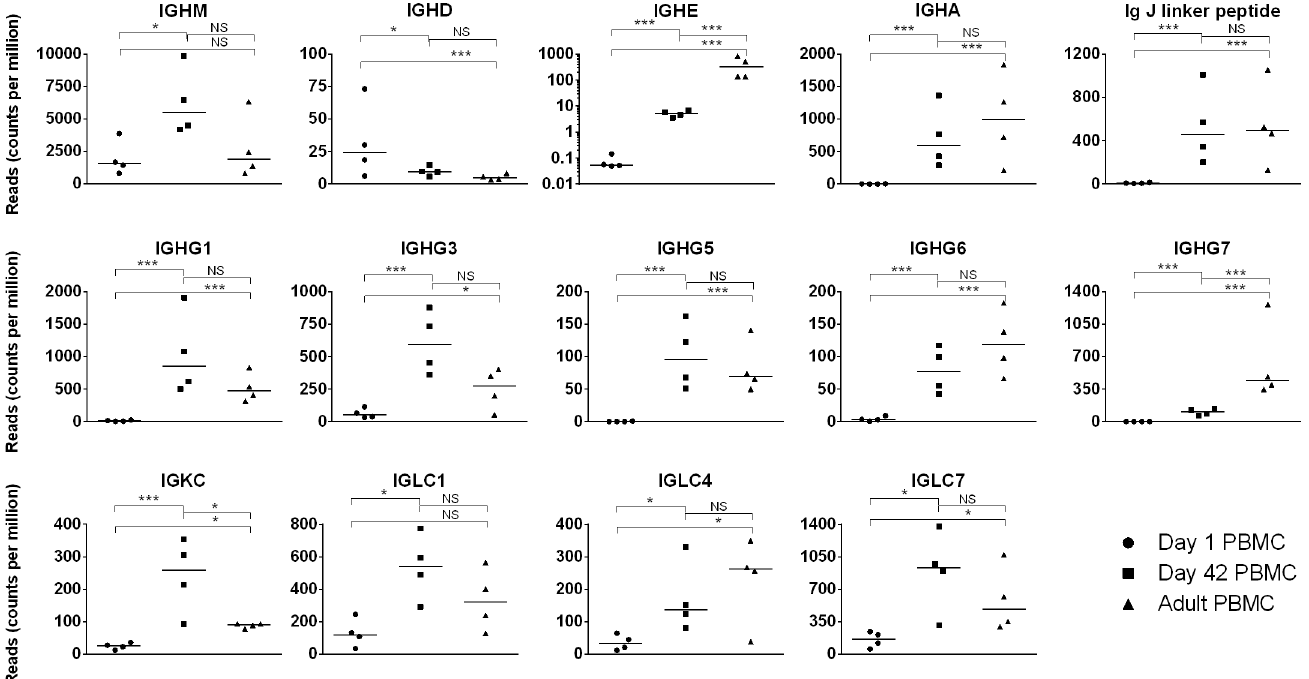
Fig 3. Immunoglobulin gene expression in day 1 foal, day 42 foal, and adult horse samples. Expression (quantified by number of reads on y-axis) of Ig heavy and light chain constant region genes and Ig J linker peptide in day 1 foal (circle), day 42 foal (square), and adult (triangle) samples are plotted on the x-axis. The significance level of comparisons is indicated by asterisks ( (cid:3) p < 0.05; (cid:3)(cid:3) p (cid:20) 0.001; (cid:3)(cid:3)(cid:3) p (cid:20) 0.0001); comparisons that did not differ statistically are labeled “NS” to denote not significant.